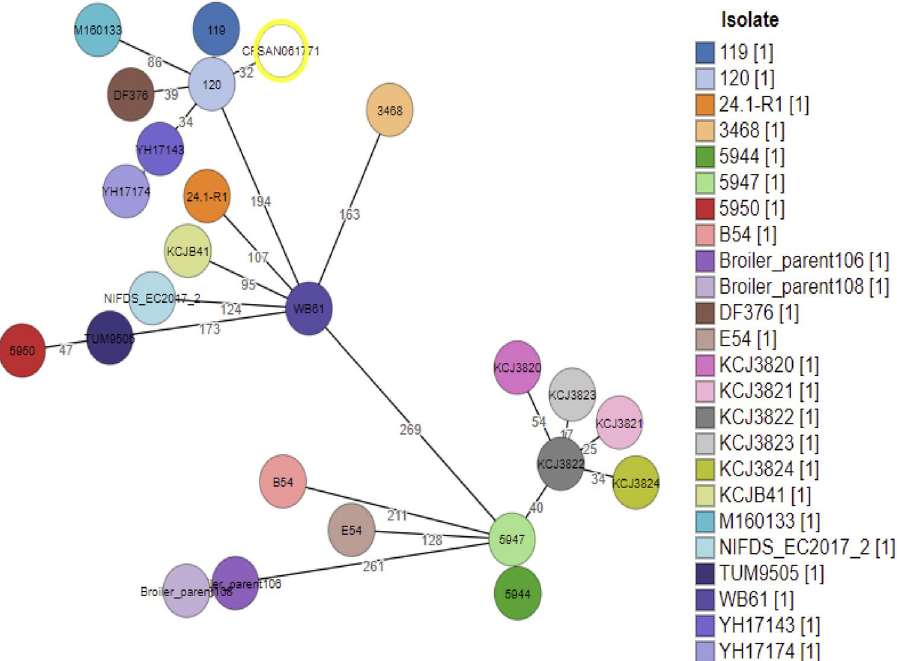
Figure 1. Phylogeny of closest relatives of CFSAN061771 based on cgMLST. The closest relative strains were identified by a core genome MLST (cgMLST) allele threshold of 500 alleles. CFSAN061771 is the white circle highlighted in yellow and the individual isolates are marked with different colors. The numbers on the branches represent the allelic